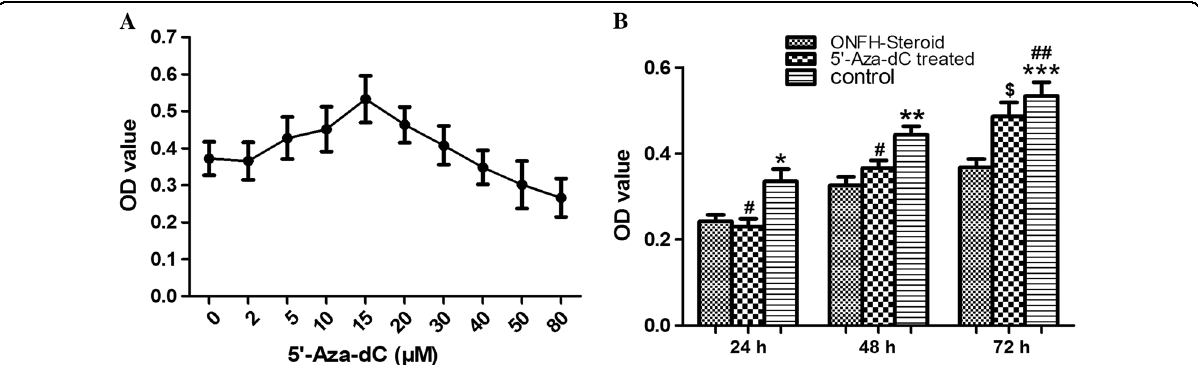
Fig. 1 Dose response curves for 5 ’ -Aza-dC-treated cultures and a cell proliferation assay. a Cellular viability reached its peak at the dosage of 15 μ M at t = 72 h. b The proliferation capacity of MSCs at t = 24 h, 48 h and 72 h. * P < 0.05 vs. ONFH group, 5 ’ -Aza-dC group at t = 24 h; ** P < 0.01 vs. ONFH group at t = 48 h; *** P < 0.001 vs. ONFH group at t = 72 h; # P > 0.05 vs. ONFH group at t = 24 h, 48 h; ## P > 0.05 vs. 5 ’ -Aza-dC group at t = 72 h; $ P < 0.01 vs. ONFH group at t = 72